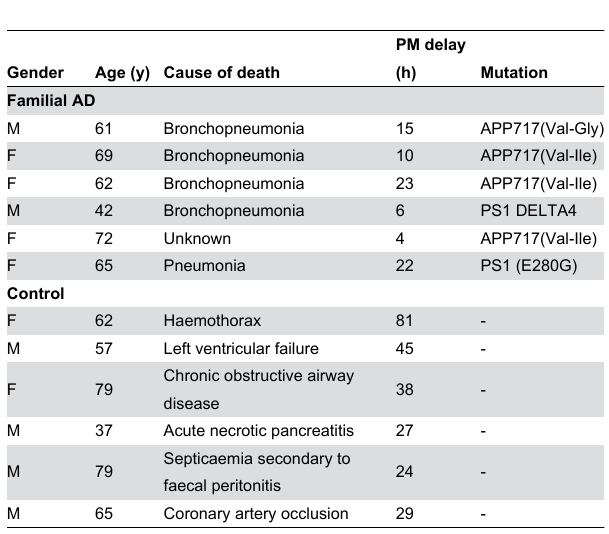
Gender Age (y) Cause of death PM delay (h)